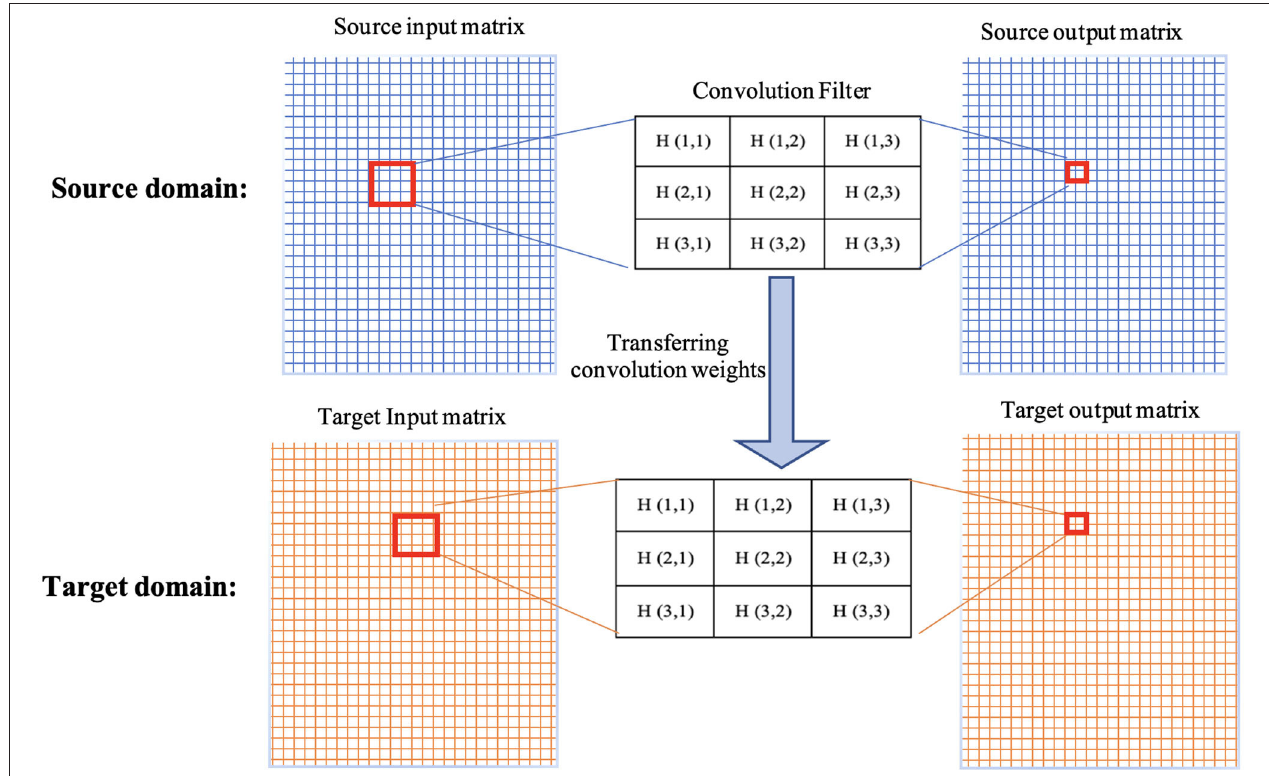
FIGURE 2 | Demonstration of transferring weights of a convolution filter from source domain to target